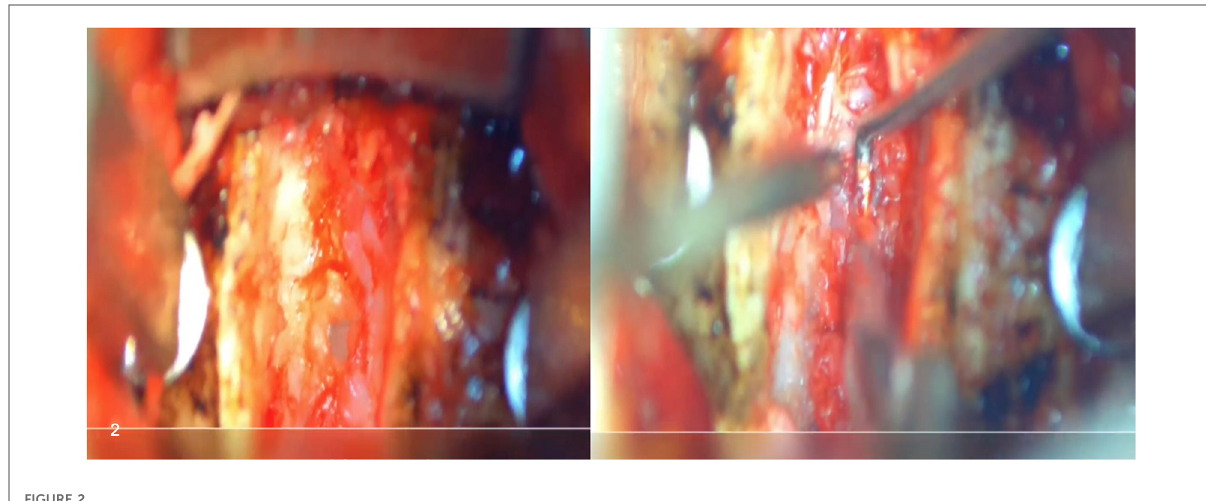
FIGURE 2 Intraoperative visualization of an ACDF procedure with the